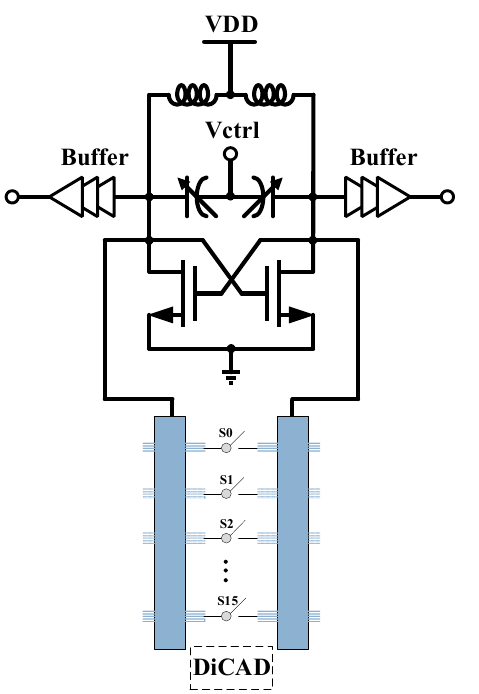
Figure 11. The schematic of the fundamental voltage-controlled oscillator.